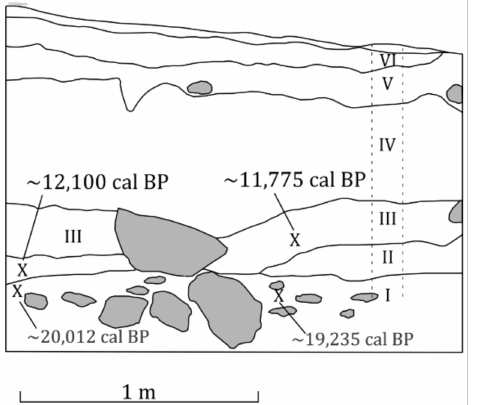
Figure 3. Stratigraphic profile of Excavation 1 from Cerro Azul showing strata (strata labeled with Roman numerals) and AMS radiocarbon dates. Dashed lines indicate the sampling column for phytolith analysis. For full profile drawing and description see Morcote-Rios et al.